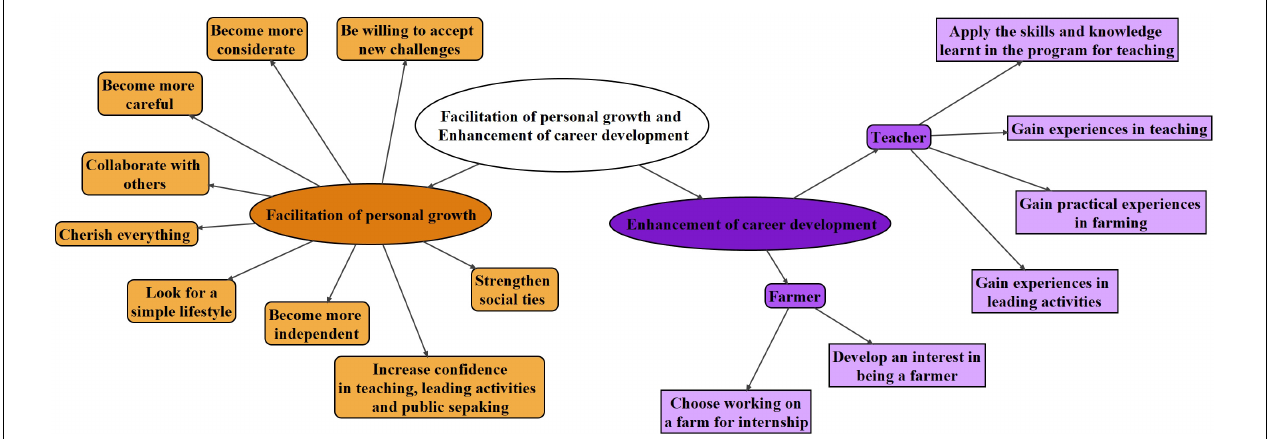
FIGURE 5 | Mapping of the codes under the themes ‘Facilitation of personal growth’ and ‘Enhancement of career development.’ Different shapes refer to different levels of